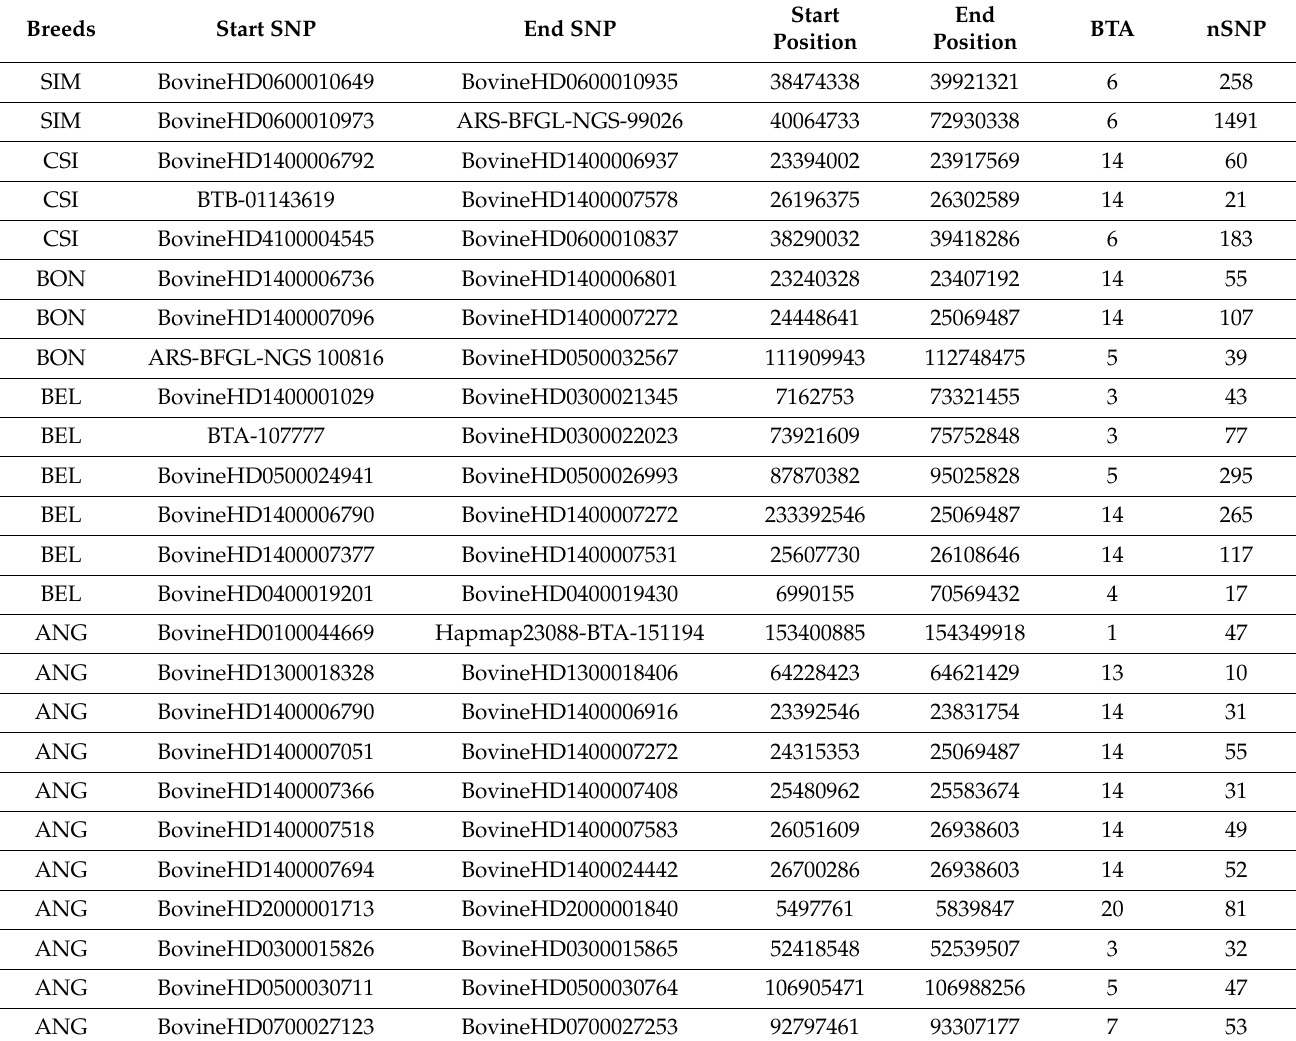
Table 1. SNP position, length, chromosome, and number of SNPs